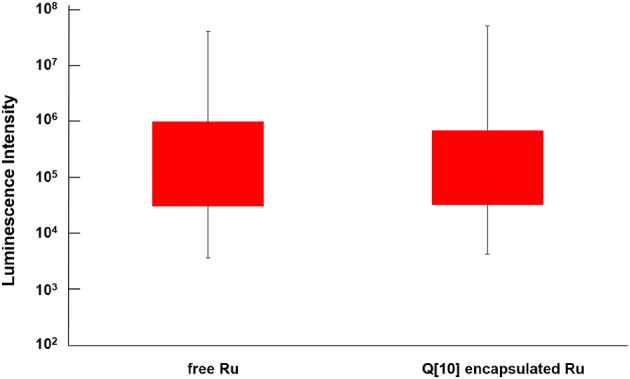
“Box and whisker” plot of the luminescence from α-Me4phen-7 accumulation in BHK cells at 25 μM after a 1-h incubation for both free and Q[10]-encapsulated α-Me4phen-7. The red box region shows the 25–75% quartiles for the luminescence intensity per cell, while the whiskers show the maximum and minimum intensities per cell.